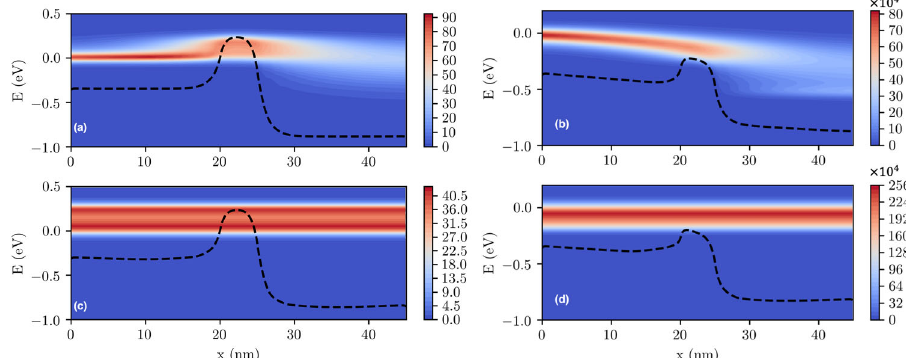
Fig. 3 Current density spectrum in an Sb-based MOSFET with L G = 5 nm. a , c in the OFF state and b , d in the ON state, considering a , b inter- and intravalley acoustic and optical scattering altogether, c , d only considering intravalley elastic acoustic scattering. The black dashed lines indicate the conduction band pro fi le. The Fermi level at the source contact is set at 0 eV, while the Fermi level at the drain contact is set at − 0.55 eV. The current density spectrum is in arbitrary